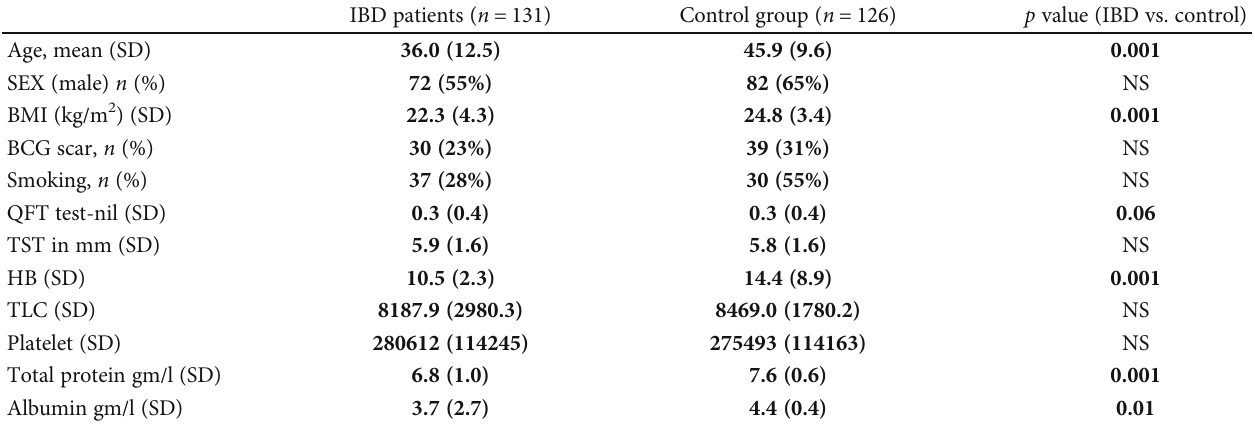
Table 2: Comparison between IBD group and control subjects.